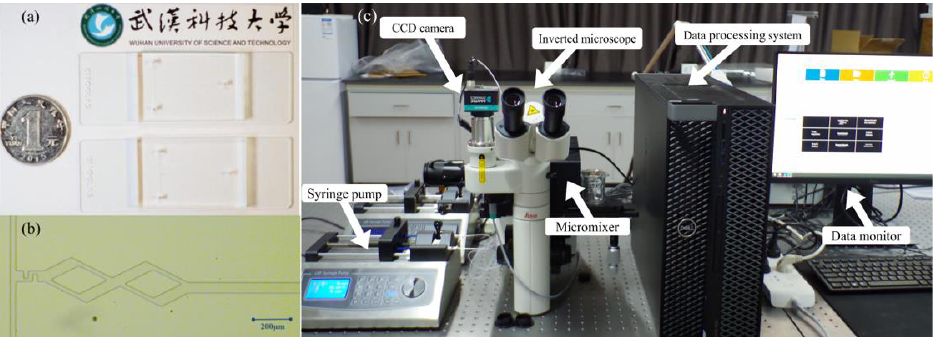
Figure 3. The photographs of the micromixer and experimental platform. ( a ) Photograph; ( b ) Pho- tomicrograph; ( c ) Mirco-PIV. experimental platform